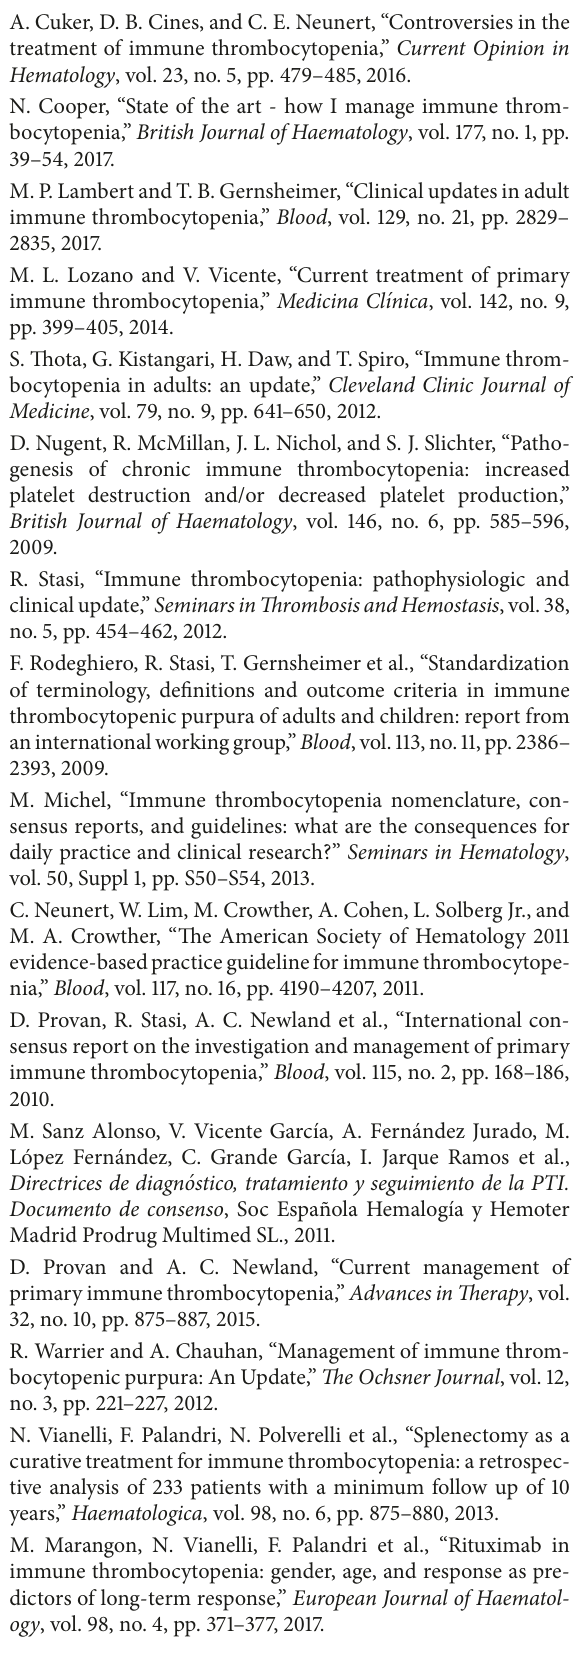
Supplementary Table 1. Results of the different sections of the questionnaire. (Supplementary